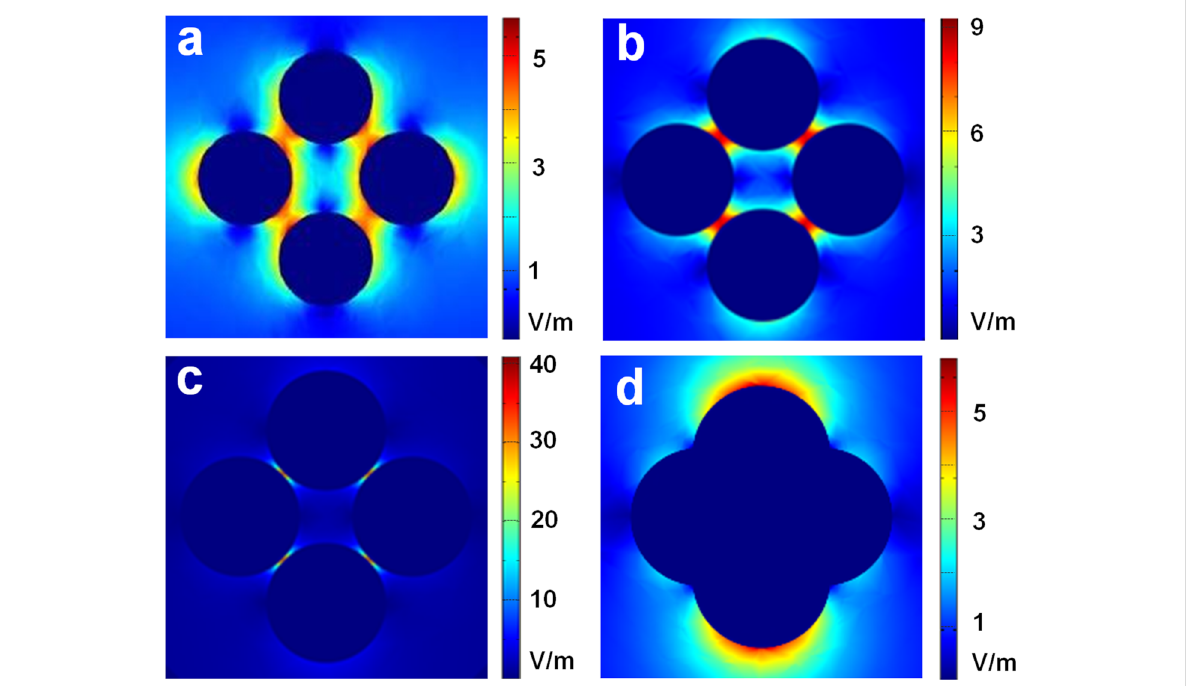
Figure 5: Electric field intensity distributions (indicated by the color bar) of the silver nanoparticles (diameter 70 nm) with different inter-particle spac- ings of 15 nm (a), 5 nm (b), 1 nm (c), and aggregated particles (d) at an excitation wavelength of 514 nm.